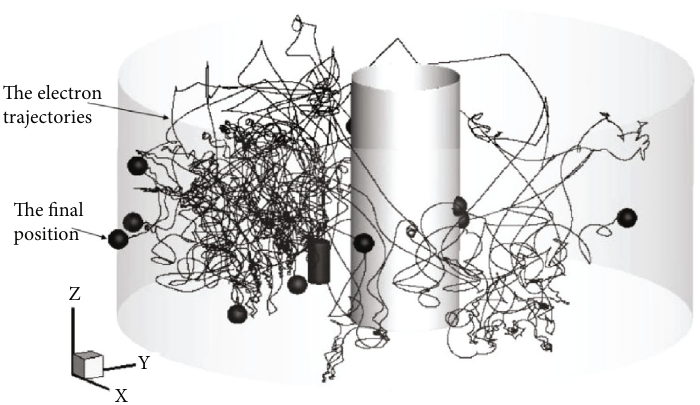
Figure 10: Distribution of Bohm, elasticity, excitation, and ionization collision.